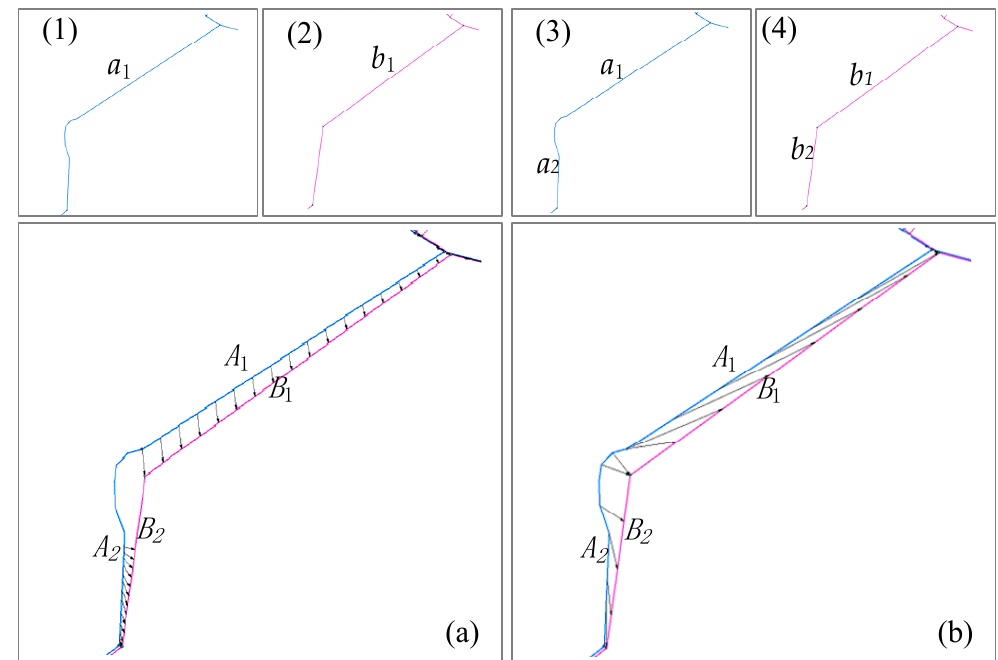
segment algorithm result. ( b ) Shows the stroke algorithm result. algorithm result. ( b ) Shows the stroke algorithm result.